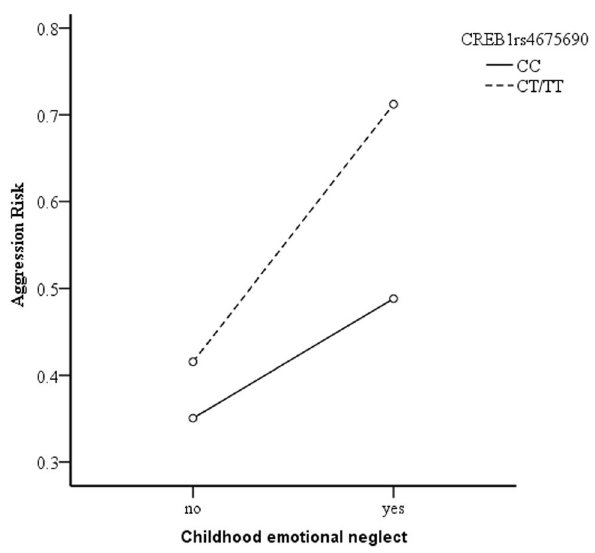
Figure 2. The interactive effect of CREB1 rs4675690 polymorphism and childhood emotional neglect on aggression